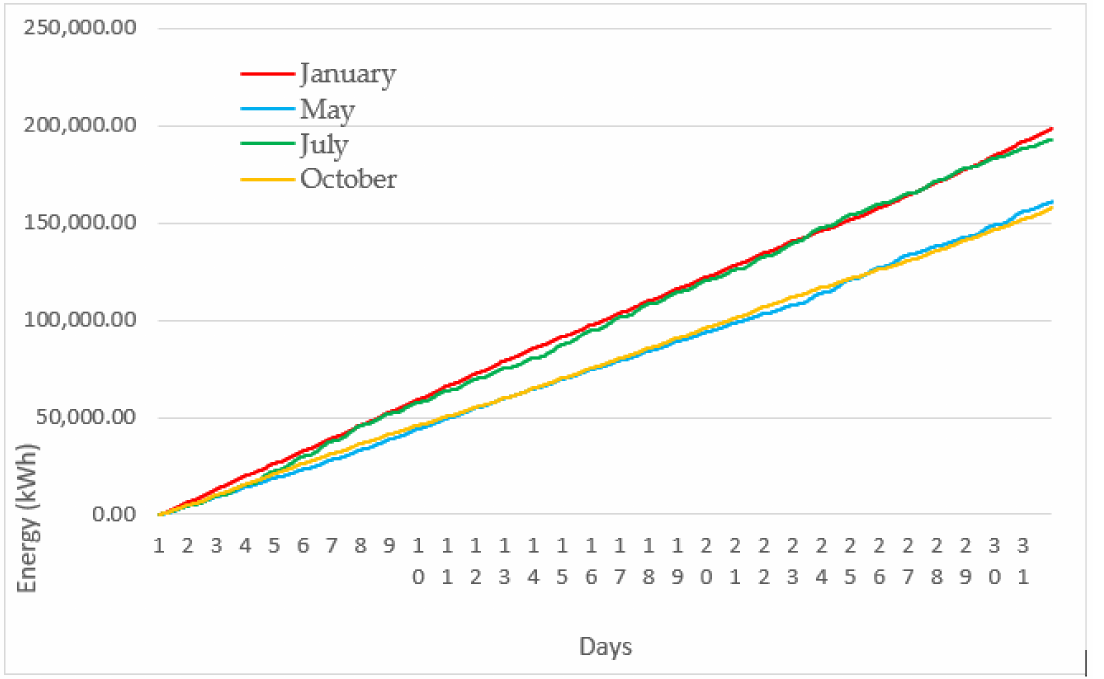
Figure 5. Daily cumulative total energy consumption of the 200